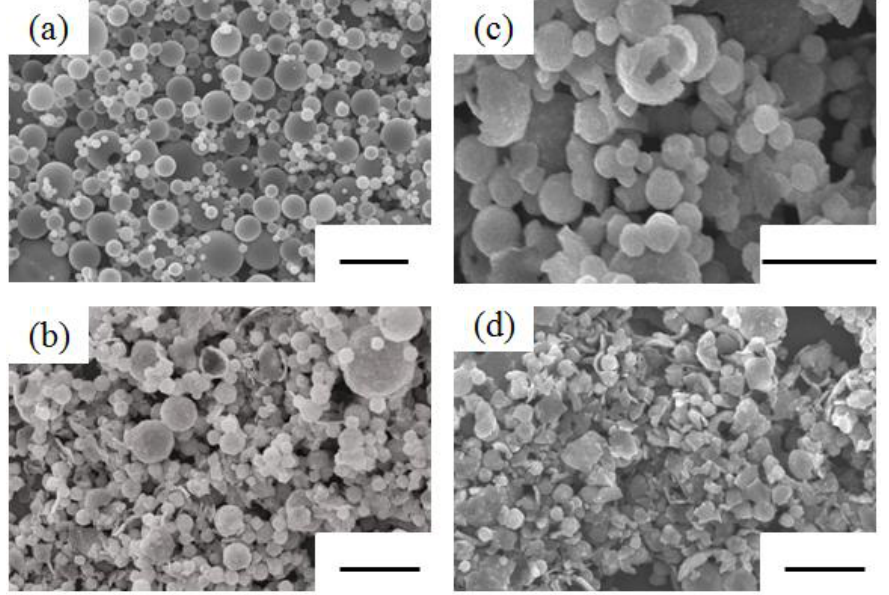
Figure 4. SEM photographs of ( a ) as-prepared powders and RLTO powders calcined